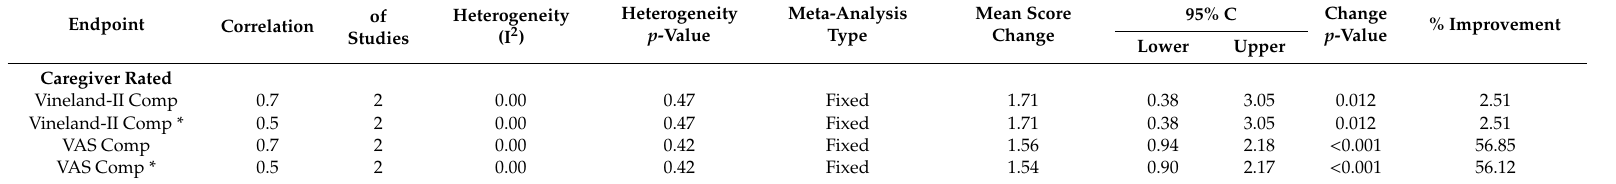
Table 4. Children with FXS in placebo-treated failed clinical trials: outcome measures improved.